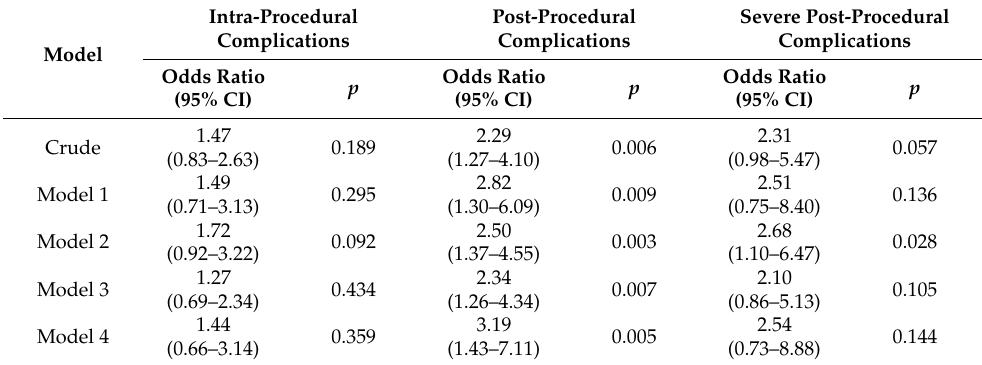
Table 4. The risk of procedure-related complications for emergent rigid bronchoscopy at the intensive care unit bedside with the OR group as the reference